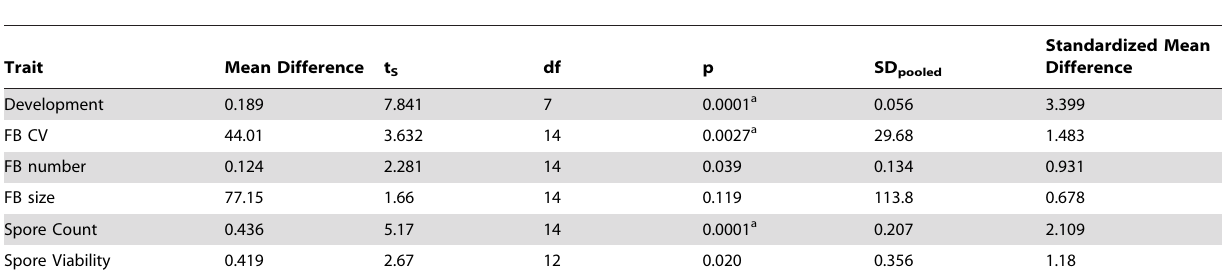
Table 3. Differences between the parental and mutant genotypes for developmental traits.